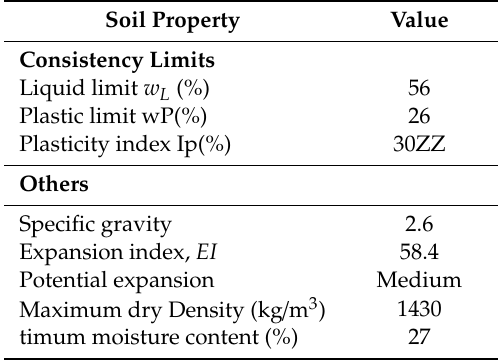
Table 1. Consistency limits and other properties of kaolin